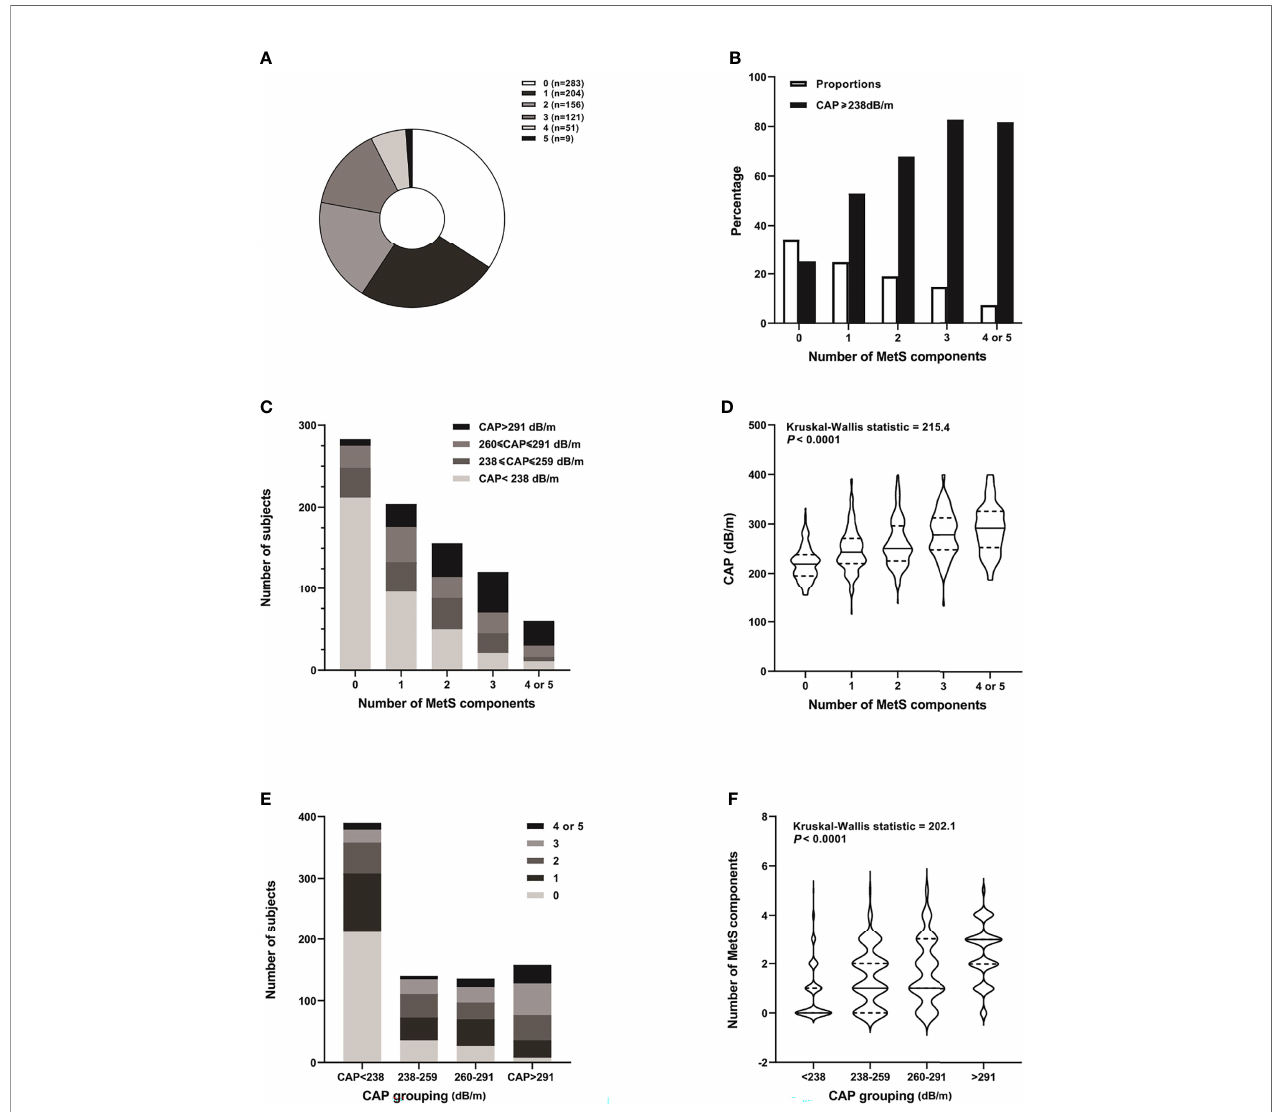
FIGURE 2 | Distribution of MetS components and CAP grades of the study subjects. (A) Pie chart distribution of the number of MetS components. (B) Proportion of subjects with different number of MetS components and percentage of those with CAP ≥ 238 db/m in each group. (C) Number of subjects with different grades of hepatic steatosis according to CAP in each MetS component group. (D) Violin chart distribution of the median and quartiles of CAP in each MetS component group. (E) Number of subjects with 0-5 MetS components in different hepatic steatosis groups according to CAP. (F) Violin chart distribution of the median and quartiles of number of MetS components in different CAP-based